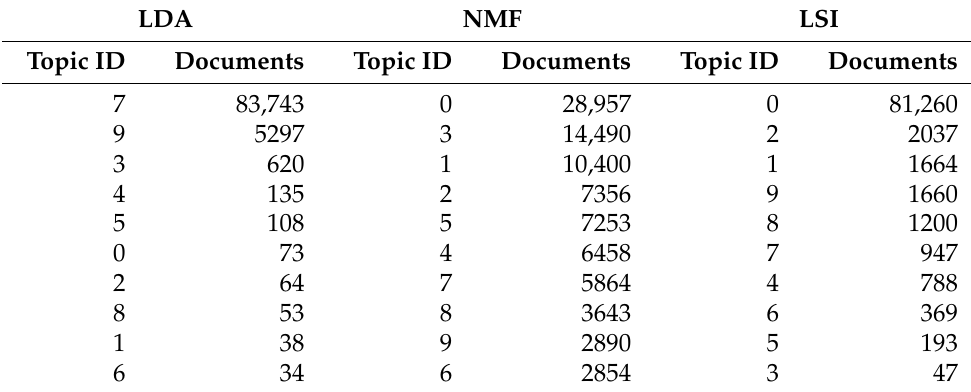
Table 2. Number of documents by dominant topic.